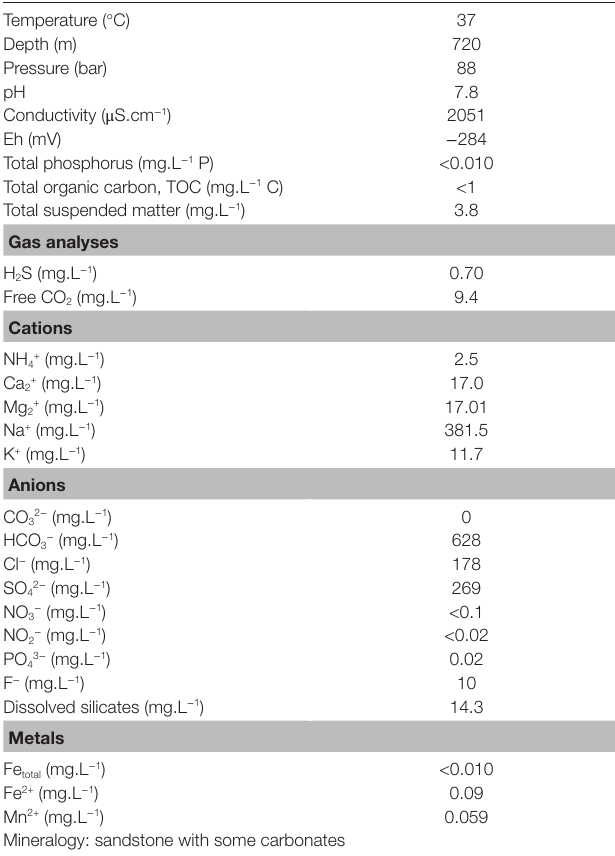
TABLE 1 | Physicochemical parameters and components of the formation water from a deep aquifer analyzed at atmospheric pressure. Temperature ( °